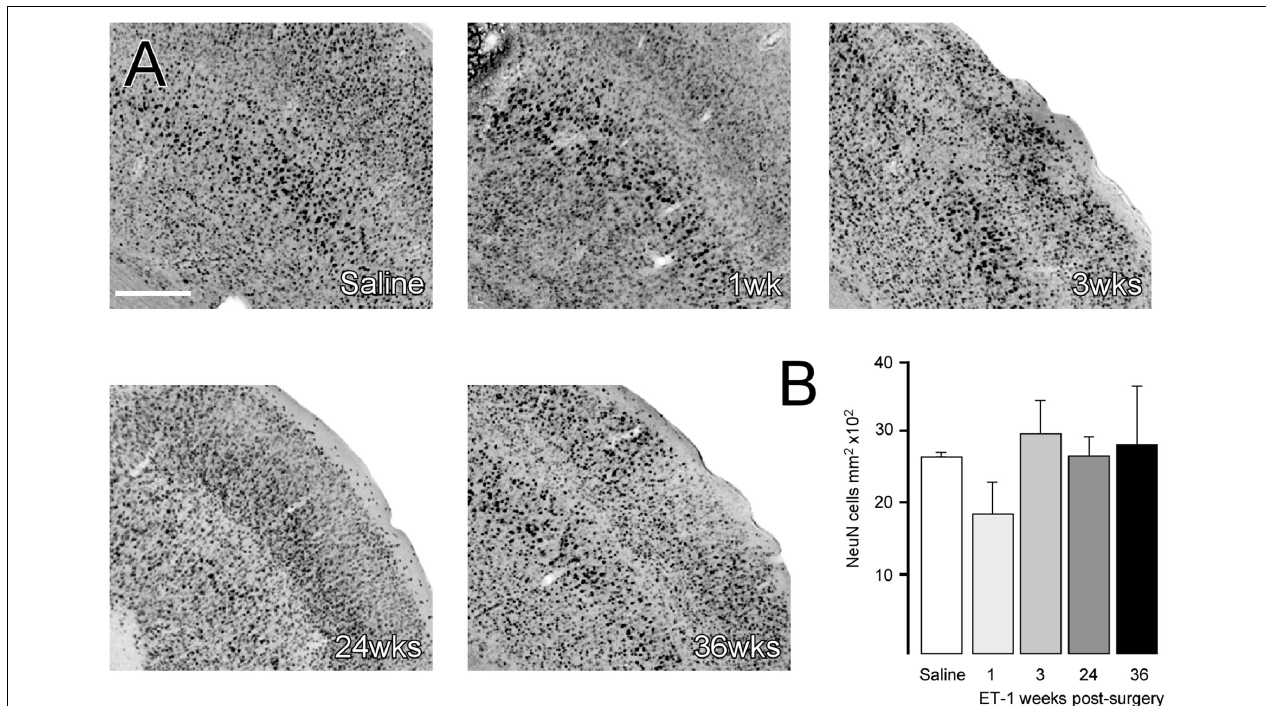
FIGURE 3 | Cortical neuronal cell density does not change in areas of atrophy. (A) Representative images of immune-labeling for NeuN in a cortical area adjacent to the injection of saline or 1, 3, 24, or 36 weeks after ET-1 injection. (B) Counting of NeuN + cells within a defined area showed that cortical neuronal density was not significantly different in atrophied cortical regions after ischemia [one-way ANOVA F 4 , 19 = 3.059, p = 0.042, Dunnett’s post hoc ; saline ( n = 6), ET-1 1 week ( n = 4), ET-1 3 weeks ( n = 4), ET-1 24 weeks ( n = 5), ET-1 36 weeks ( n = 5)]. Scale bar: (A) 500 µ m.